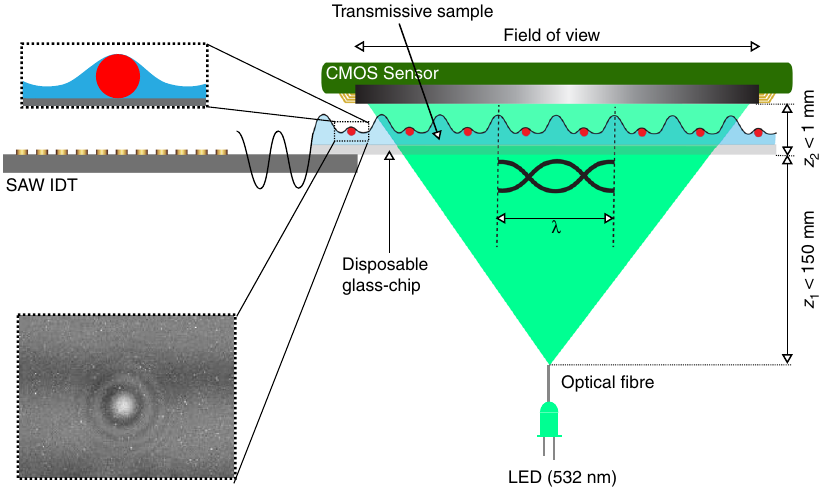
Fig. 2 Optical system design. A standing Lamb-type wave mode transformation from a SAW transducer is illustrated. This wave spatially distorts the liquid due to pressure differences. At the antinodes, the liquid forms a thin layer over nanoparticles. This creates a localized lensing effect, enhancing the optical signal and hence the detection of nanoparticles in liquid. The height of the wave can be tuned by adjusting the input power which allows the tuning of the lensing